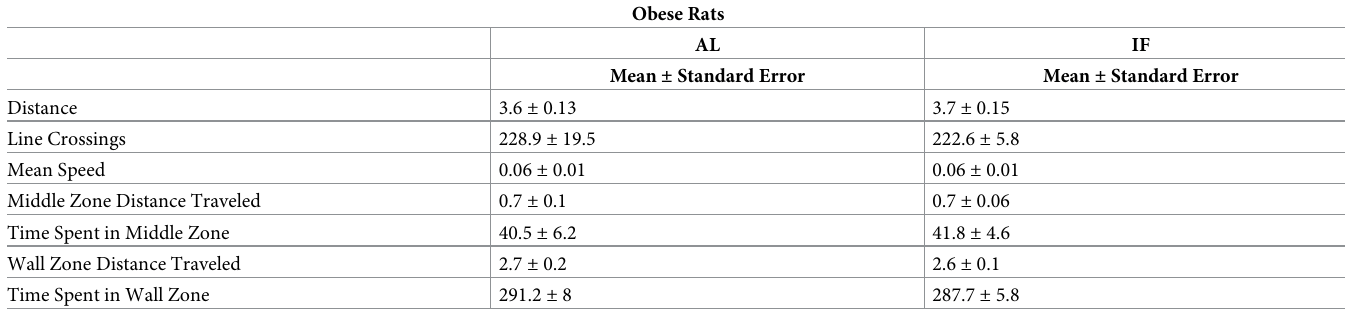
Table 6. Open field measurements in obese